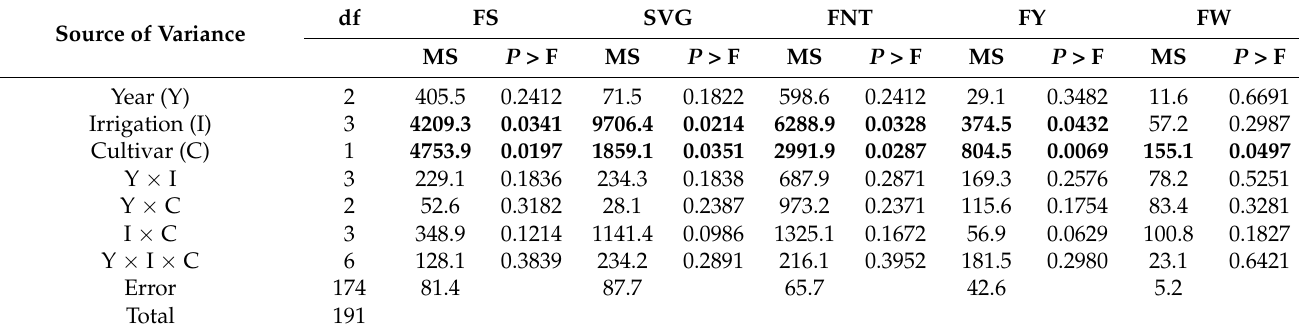
Table 6. Analyses of variance for the effects of year, deficit irrigation treatment and cultivar on yield related measures of tree physiological properties (fruit set—FS, seasonal vegetative growth—SVG, fruit number per tree—FNT, fruit